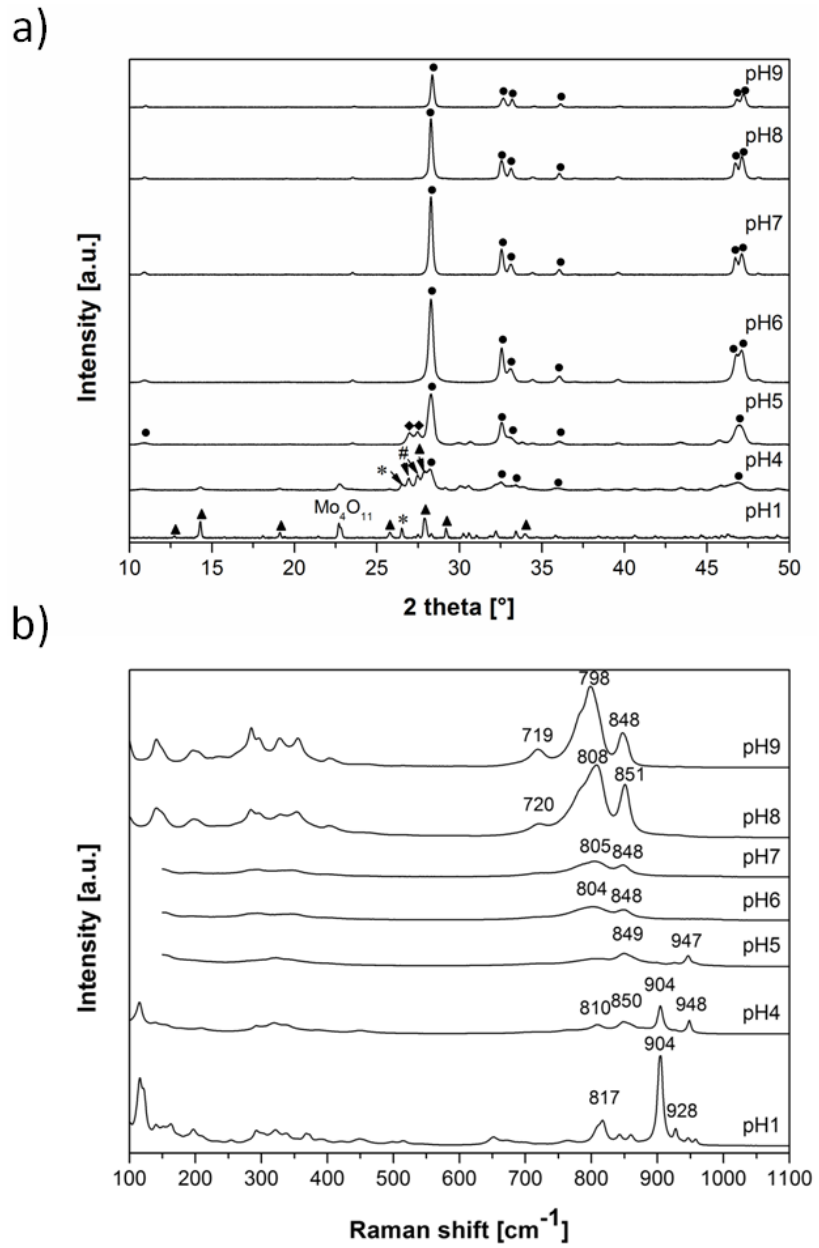
Figure 1. XRD patterns ( a ) and Raman spectra ( b ) of the samples with Bi/Mo = 1/1 at different pH values. The following symbols are used for the different phases: α-Bi 2 Mo 3 O 12 (▲), γ-Bi 2 MoO 6 (●), MoO 3 ∙2H 2 O (♦), Bi 2 O 3 (*) and Bi 26 Mo 10 O 69